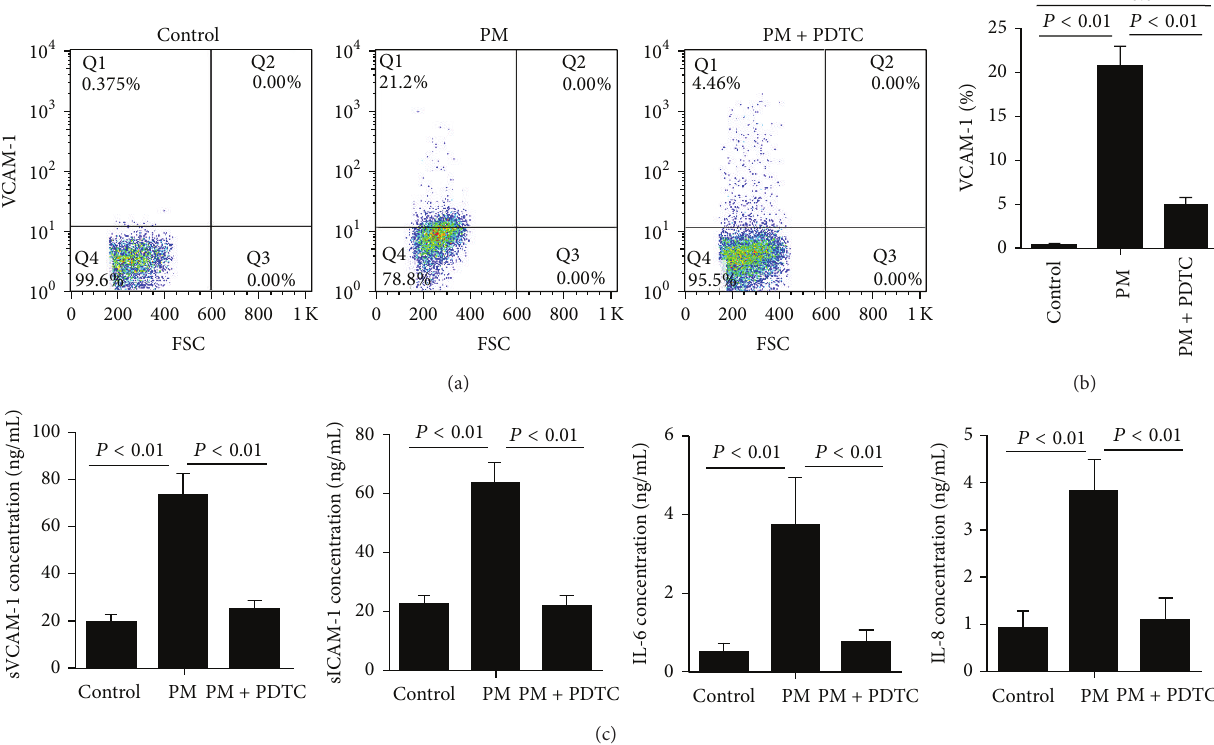
Figure 7: PDTC inhibits PM-induced inflammatory responses. HUVECs were pretreated for 30min with the NF- 𝜅 B inhibitor PDTC (10 𝜇 mol/L) before stimulation with PM (100 𝜇 g/mL) for 24 h. The adhesion molecules and inflammatory cytokines were detected by flow cytometry and Elisa. (a) Dot plots showing the percentages of VCAM-1 expression in HUVECs. (b) The VCAM-1 expression in different groups of HUVECs. (c) The concentration of sVCAM-1, sICAM-1, IL-6, and IL-8 in the supernatants from different groups of HUVECs. Data are expressed as means ± SEM of 5 independent